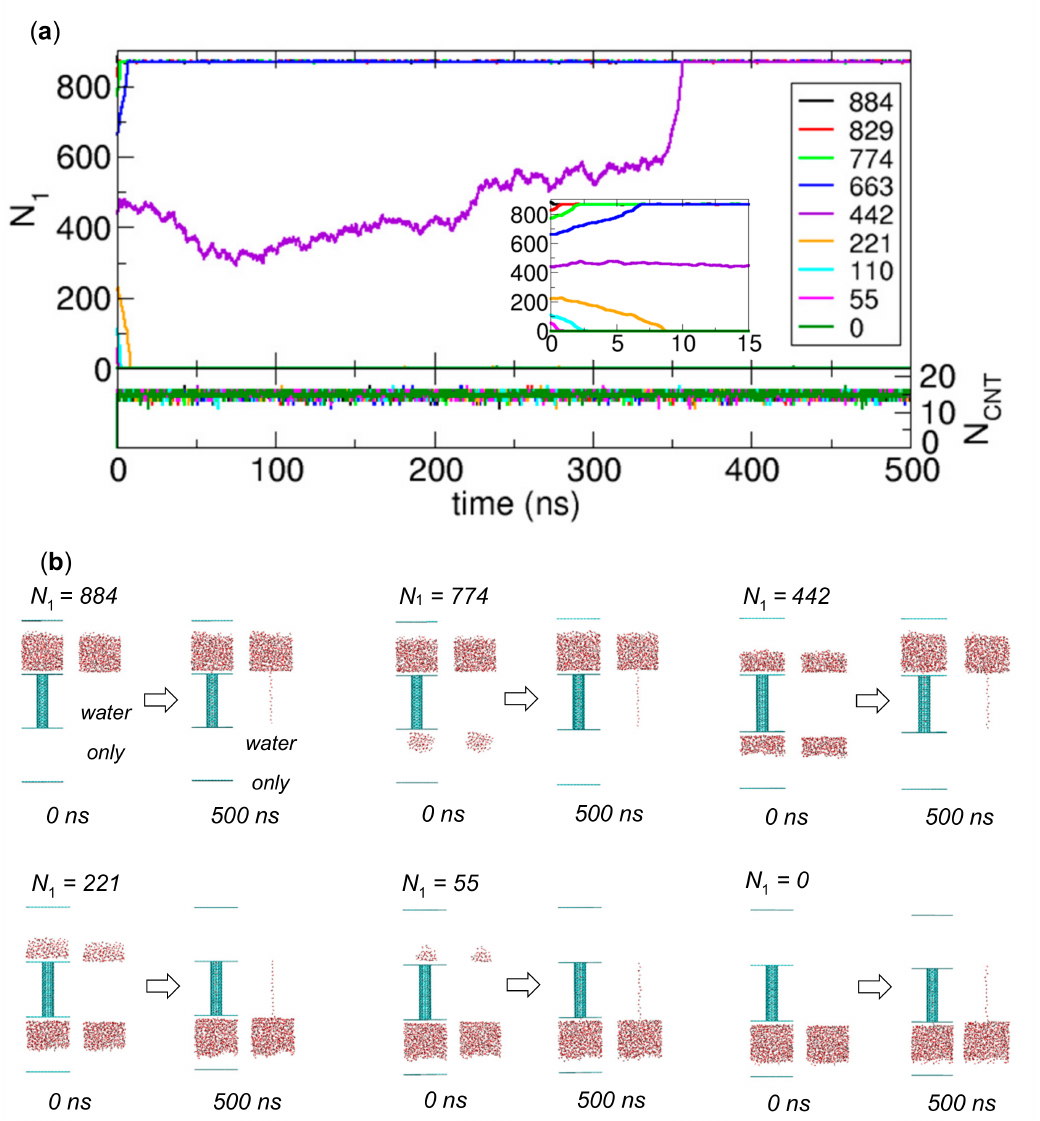
Figure 5. Transport simulation of water molecules in various systems of compartment walls that weakly interact with water molecules in the absence of osmolytes. Various initial configurations with N 1 = 884, 829, 774, 663, 442, 221, 110, 55 and 0 are prepared from the 10 ns equilibration process. ( a ) Numbers of water molecules in Compartment 1 ( N 1 ) and the CNT ( N CNT ) as functions of time. The inset show the plots for a time interval from 0 ns to 15 ns. ( b ) Initial and final configurations obtained from the 500 ns MD simulations for various initial configurations with N 1 = 884, 774, 442, 221, 55 and